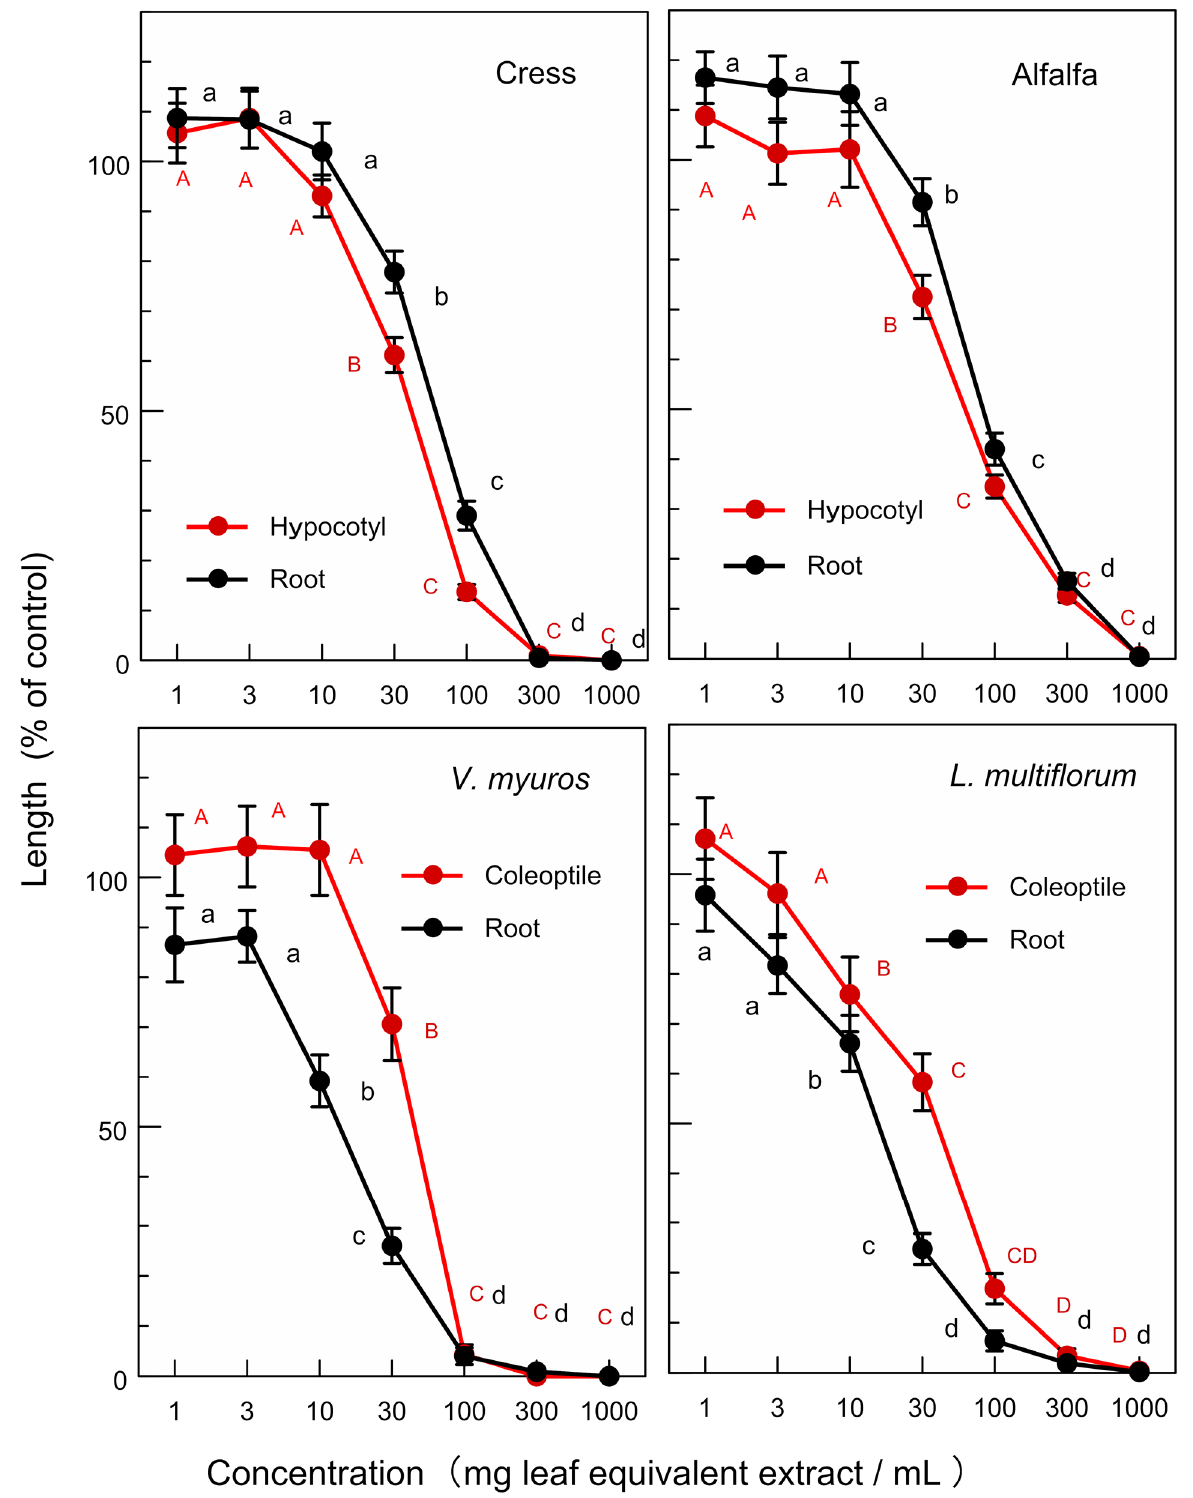
Figure 4. Effects of the extracts of O. heterophyllus leaves on the growth of the hypocotyls and roots of cress and alfalfa, and the growth of the coleoptiles and roots of L. multiflorum and V. myuros . Concentration (mg leaf equivalent extract/mL) indicates the concentration of the tested sample corresponding to the extracts obtained from 1, 3, 10, 30, 100, 300, and 1000 mg leaves per mL. Different letters on the symbols in the same panels indicate significant differences (Tukey’s HSD test, p ≤ 0.05).